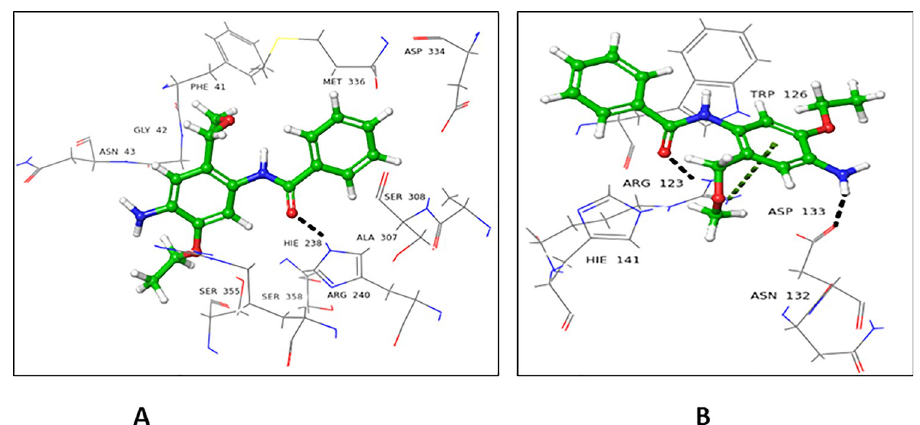
Fig 6. Interactions of compound 2 with ( A ) donor and ( B ) acceptor site. 3D Ligand interactions diagram; black dashed lines show hydrogen bonds; green dashed lines indicate π -cation interactions.